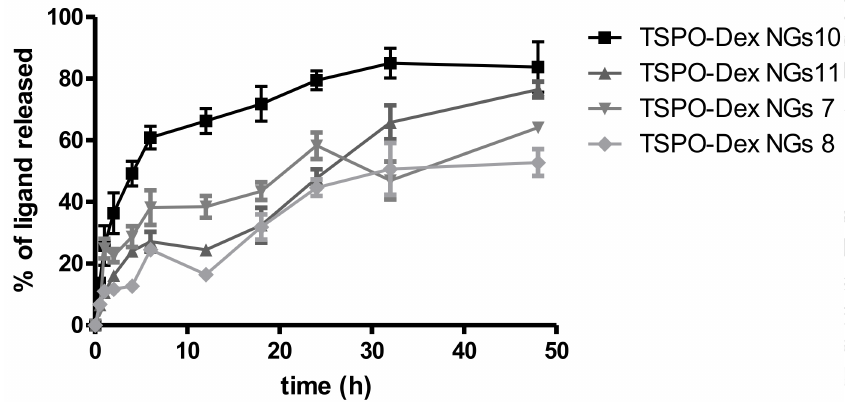
Figure 10. Release profile of TSPO-DEX nanogels (NGs) in diluted human serum at 37 ± 0.2 ◦ C and pH